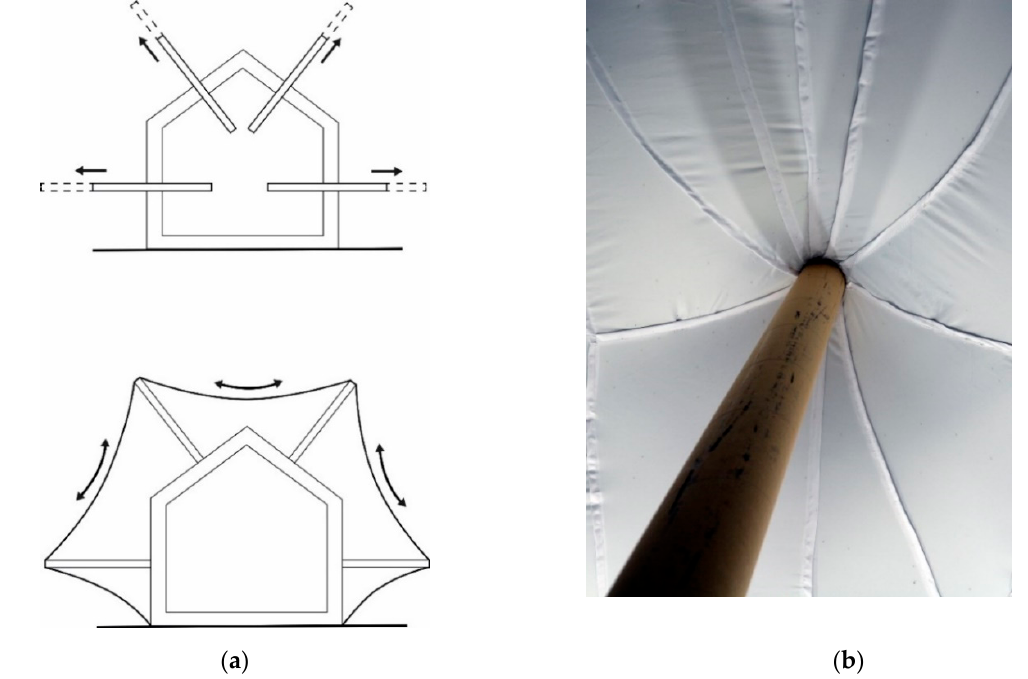
Figure 16. Stretching the outer skin membrane: ( a ) diagram illustrating the stretching of the membrane with paper tubes; ( b) paper rod used to stretch the membrane.